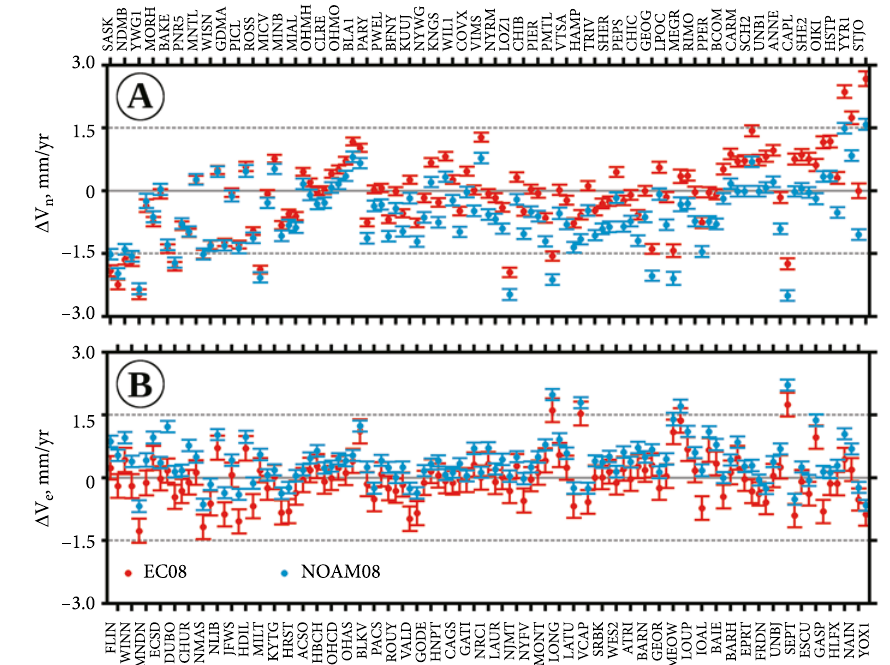
Fig. 5. (A) North and (B) east postfit residual velocities for all stations except MINW, HULL, GAS2, GODR, and MCHN. Stations are sorted according to their longitudes. In general, the postfit residual velocities calculated from eastern Canada ITRF 2008 (EC08) model are smaller especially for stations located at the Saint Lawrence River